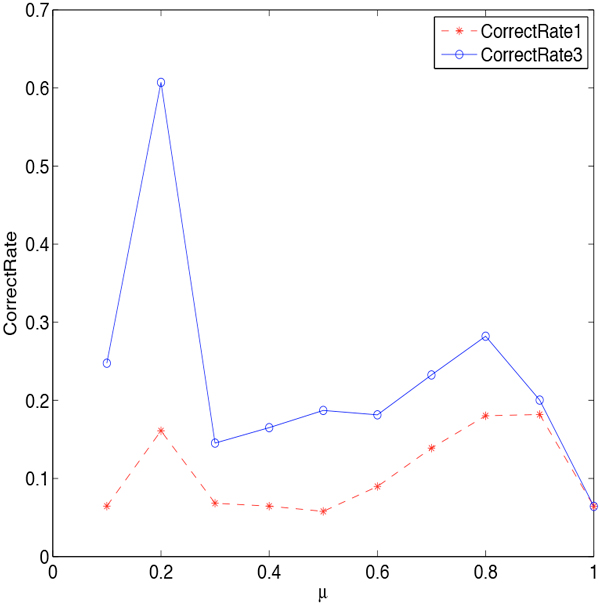
Parameter Sensitivity of µ in Dirichlet Priors BPLT+. The influence of parameter µ is studied: (1) the stars represent the performance of Dirichlet Priors BPLT+ under the evaluation metric CorrectRate1; (2) the circles represent the performance of Dirichlet Priors BPLT+ under the evaluation metric CorrectRate3; (3) Dirichlet Priors BPLT+ achieves its best performance when µ = 0.2.